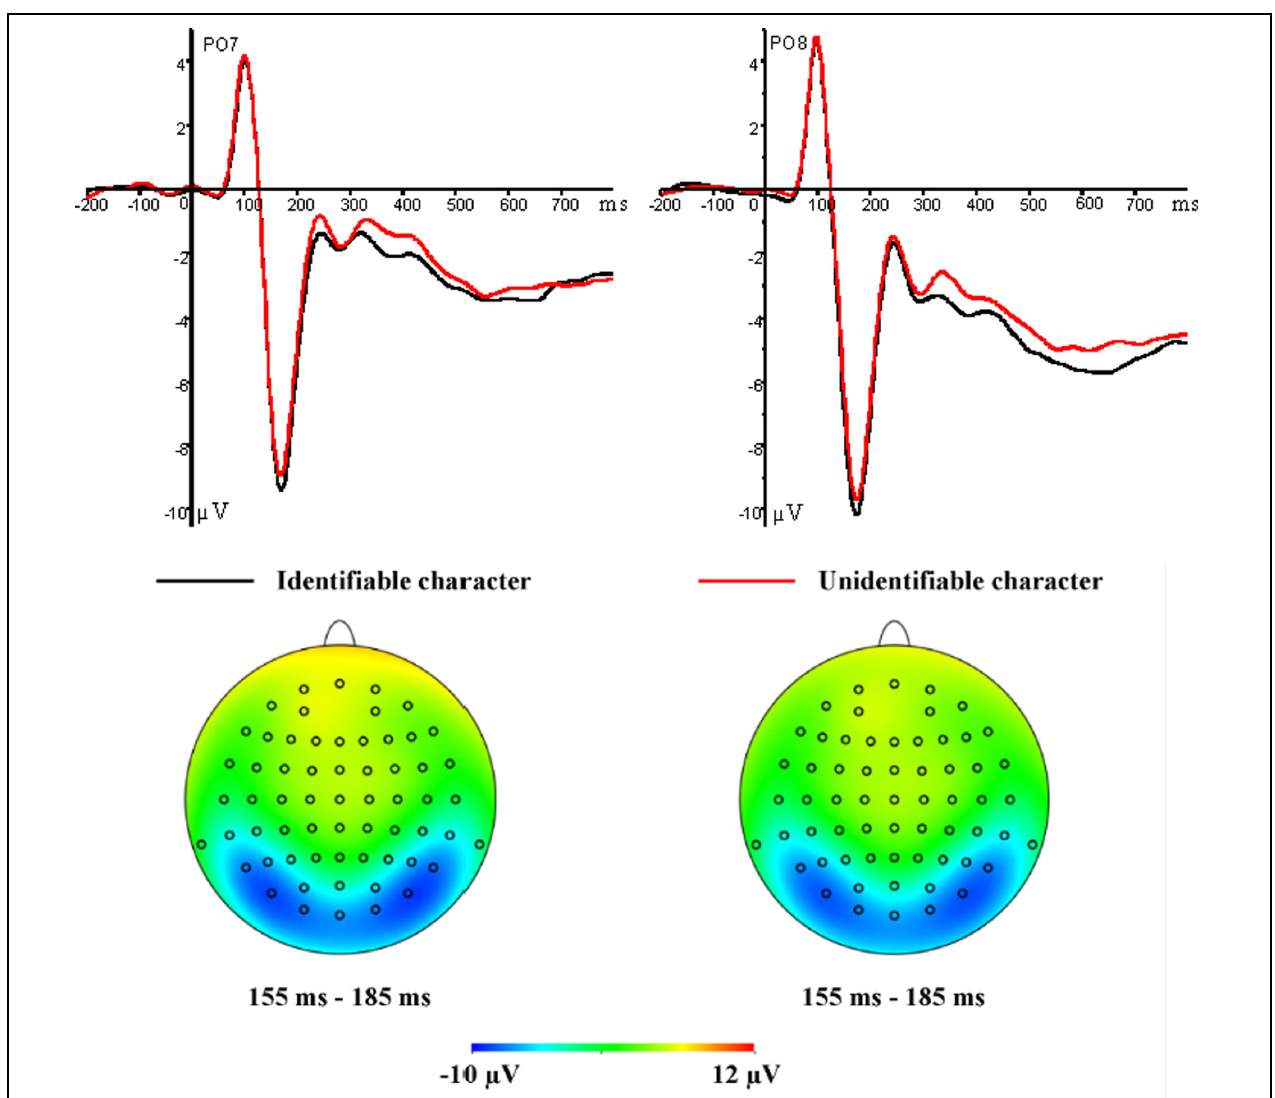
FIGURE 3 | Grand average ERP waveforms for identifiable character (black lines) and unidentifiable character (red lines) conditions recorded at PO7 and PO8 electrode sites (Top row). Topographic maps for identifiable characters (Left) and unidentifiable characters (Right) at 155–185 ms (Bottom row)